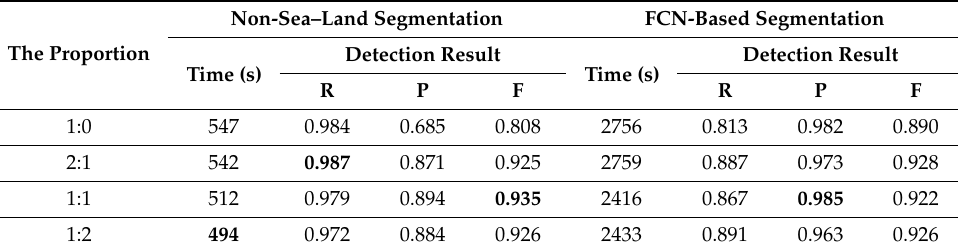
Table 7. Results and time spent for detection of the second GF-2 image.